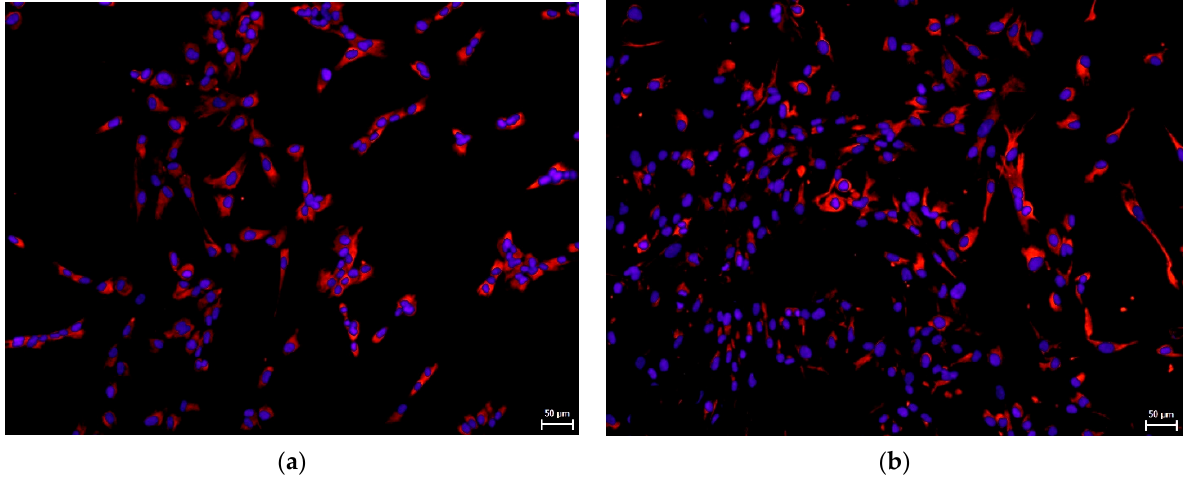
Figure 6. Immunocytochemical detection of Nestin, the neural progenitor marker, in undifferentiated hNDP-SCs harvested in the 7th passage. Most cells were positive for Nestin (red fluorescence). Cell nuclei fluorescent blue. Scale bare 50 μ m: ( a ) hNDP-SCs cultivated in the FBS-culture medium; ( b ) hNDP-SCs cultivated in the hPL-culture medium.